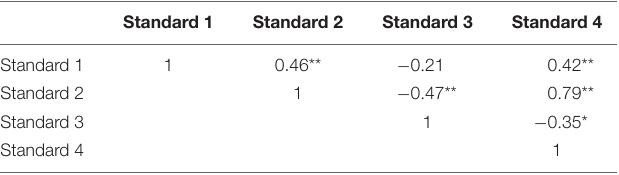
TABLE 8 | Correlations between latent classes based on model parameters on dilemmas 2 and